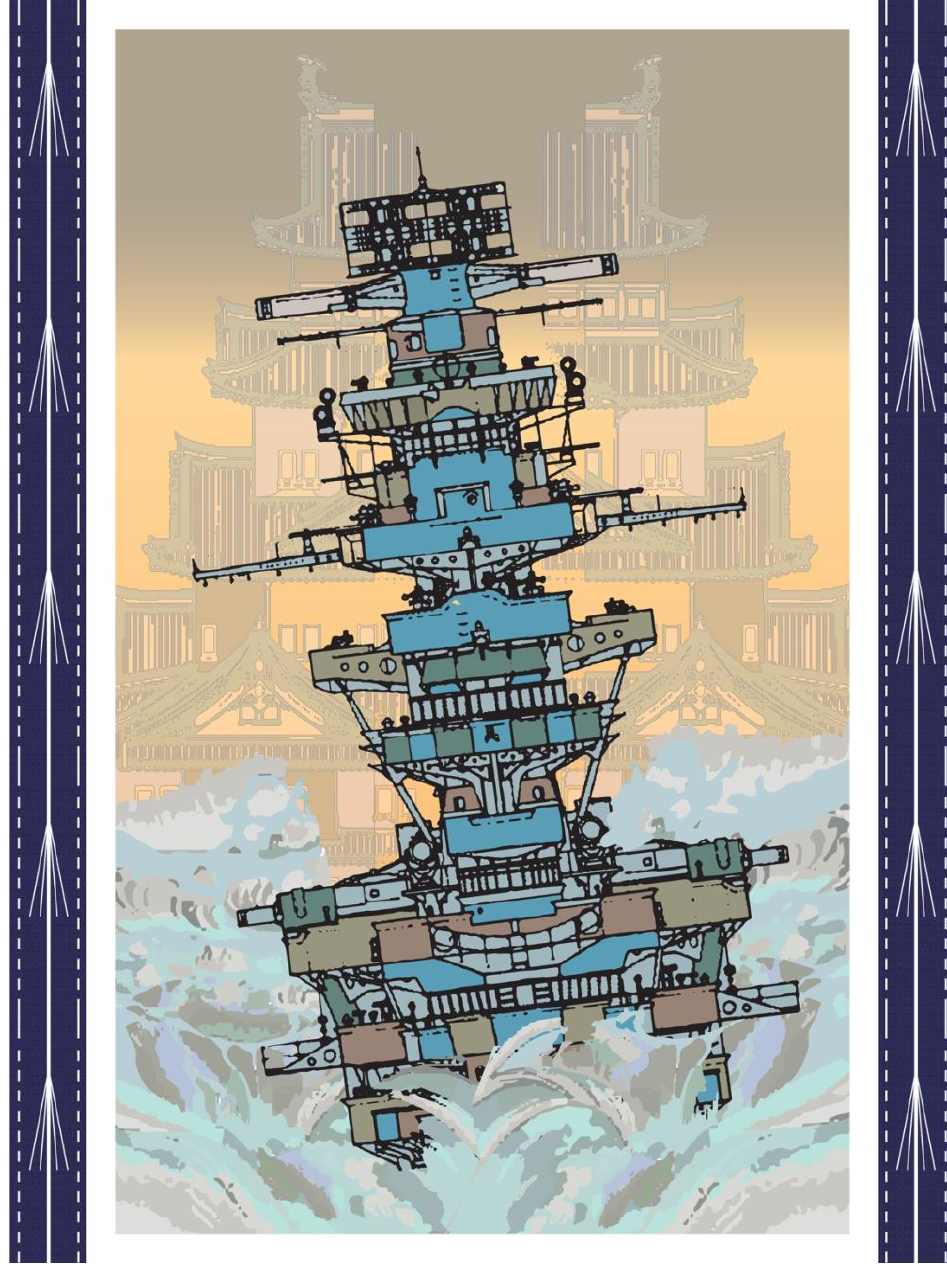
Kio Griffith, Eight Views of the Sun Setting on the South Pacific / Castle Ruins , 2020. Digital collage print on